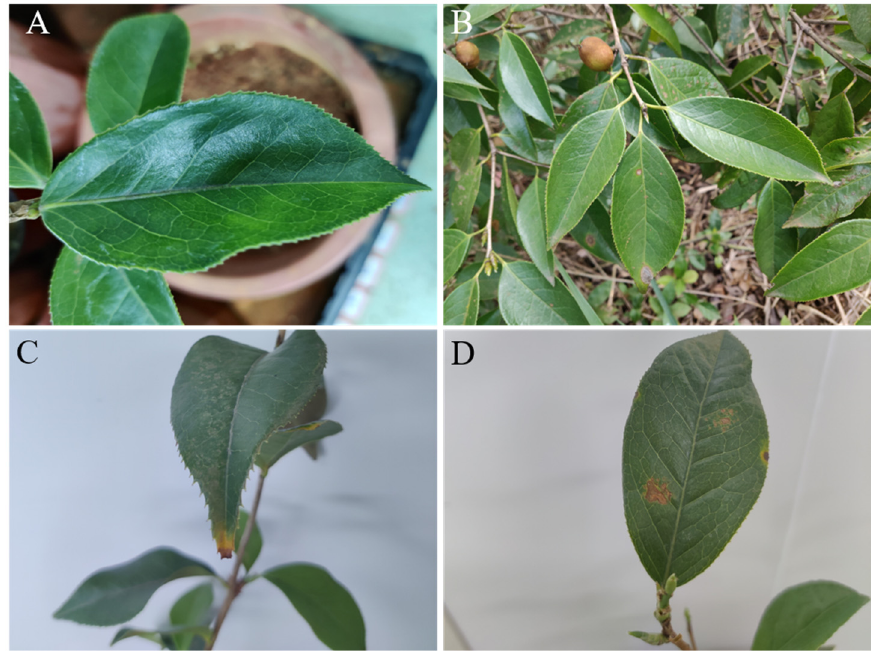
Figure 1. Typical symptoms of anthracnose on Camellia yuhsienensis . ( A ) No symptoms were observed on control leaves treated with sterilized water; ( B ) Anthracnose symptoms on Ca. yuhsienensis in a plantation in Youxian, Hunnan Province, China; ( C ) Anthracnose symptoms were seen on attached, unwounded leaves treated with a conidial suspension (1 × 10 6 conidial/mL) of isolate YX2-5-2; ( D ) Anthracnose symptoms were seen on attached wounded leaves treated with a conidial suspension (1 × 10 6 conidial/mL) of isolate YX2-5-2.